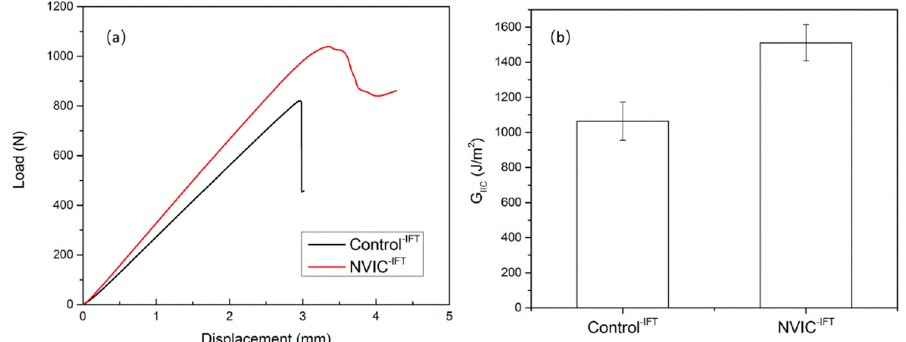
Figure 9. Results of the Mode II toughness test. ( a ) ENF load-displacement curve, ( b ) Mode II interlaminar toughness.